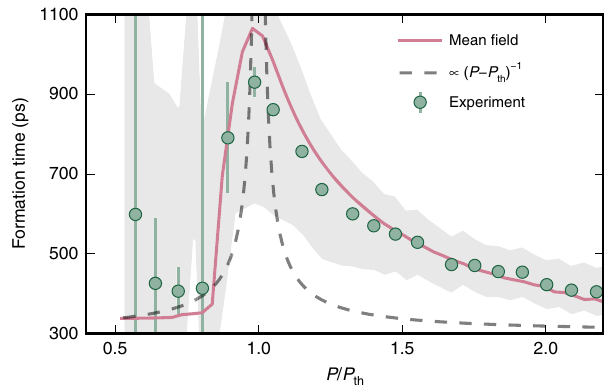
Fig. 4 Condensate formation time. The condensate formation time, de fi ned as the interval between the pump pulse and the peak photon number, displays a transient analogue of critical slowing down. The formation time and corresponding error bars are obtained by fi tting Gaussian pro fi les in a neighbouring region around the peak photon number. The full-red and black-dashed lines are the mean- fi eld simulations and the critical (power- law) divergence of condensate formation time for the lossless case, respectively. The shaded area depicts the increasing pulse width upon approaching the critical excitation fl uctuations, approaching the limit of a Markovian bath. This limit is at the origin of the observation of grand-canonical number statistics in photon BECs 17 .